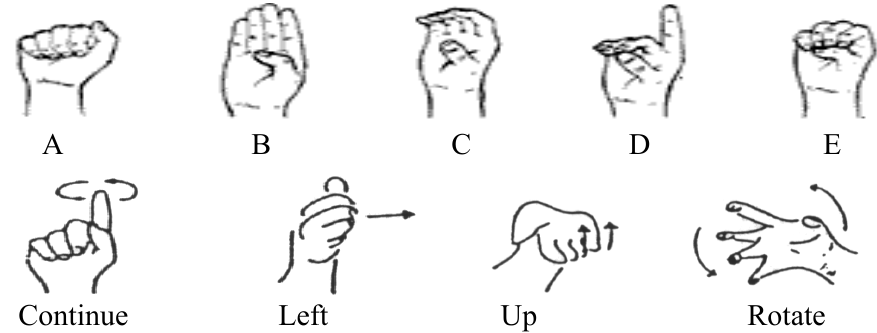
Figure 1. The hand postures for the letters ( A – E ) are represented above, while example gestures are shown